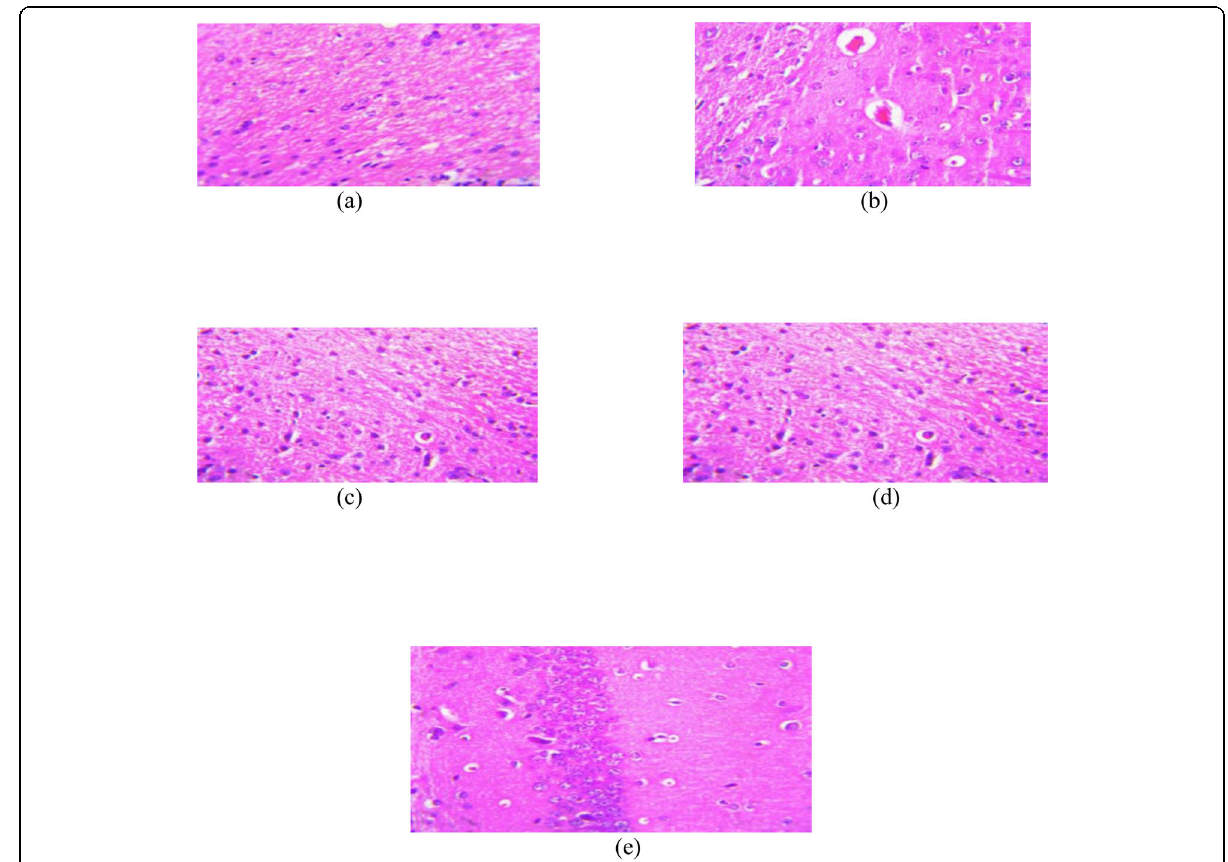
Fig. 12 Histopathological estimations (H&E stain ×